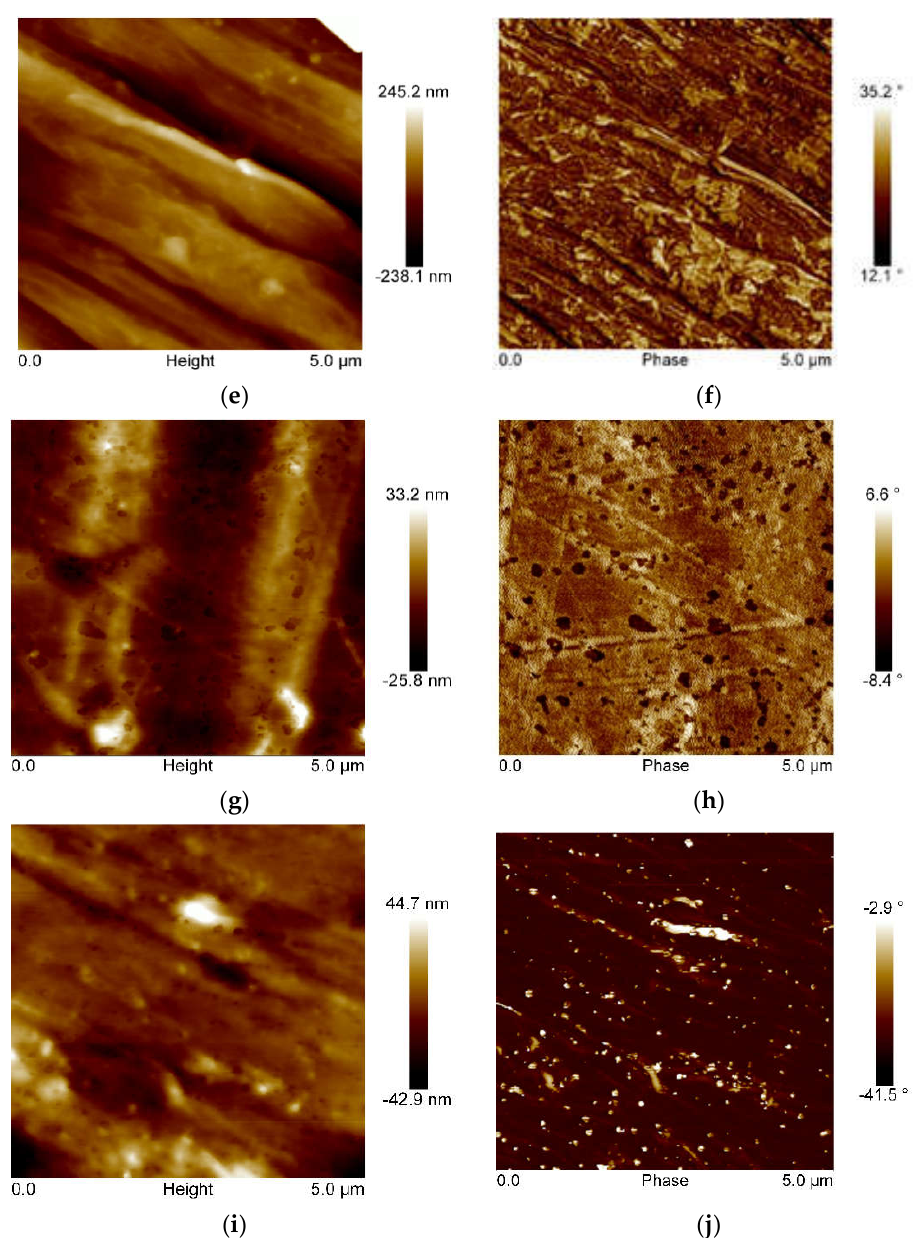
Figure 6. AFM images showing topographies for: ( a ) PET-G, ( c ) PET-G/3%S, ( e ) PET-G/3%B, ( g ) PET-G/3% L, and ( i ) PET-G/1,5%L/1.5%B; and phase images for: ( b ) PET-G, ( d ) PET-G/3%S, ( f ) PET-G/3%B, ( h ) PET-G/3%L, and ( j ) PET-G/1.5%L/1.5%B. Table 5. Summary of the obtained MFR results.